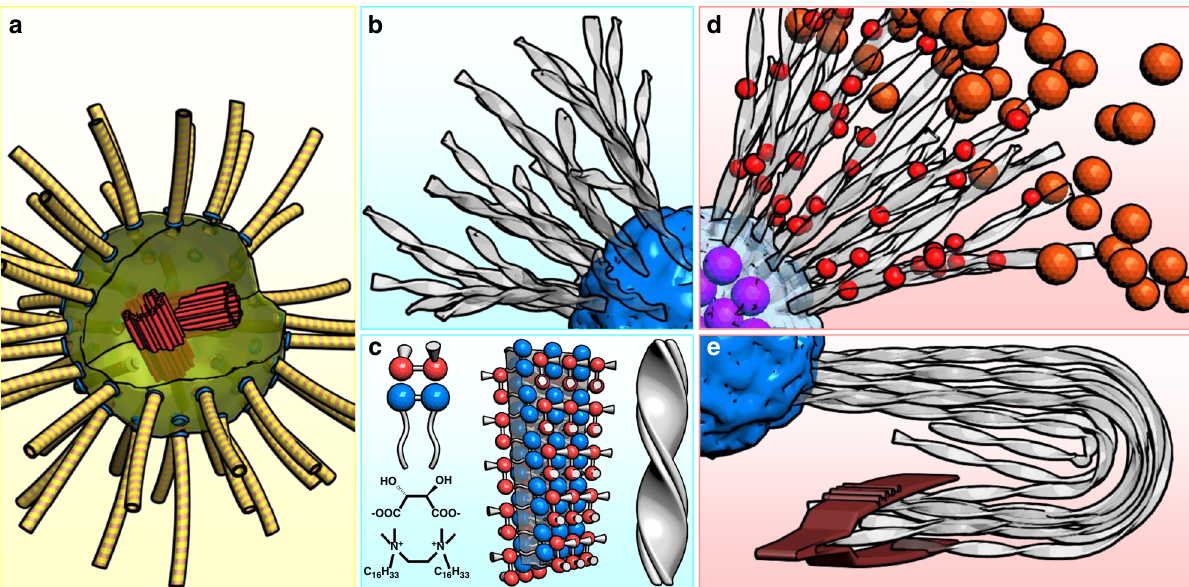
Fig. 1 Schematic representations of microtubule and synthetic asters. a A pair of centrioles (red) assemble pericentriolar material to form a centrosome (light green) with γ -tubulin rings (blue) on its surface to initiate microtubule formation (yellow), producing a microtubule aster. b , c A gemini surfactant with a chiral counterion self-assemble into synthetic asters with an amorphous core and twisted ribbons made of crystalline bilayers. d The aster can radially position particles according to respective sizes and surface chemistry. e The aster is highly elastic and deformable, featuring semi fl exible ribbons that can be bent